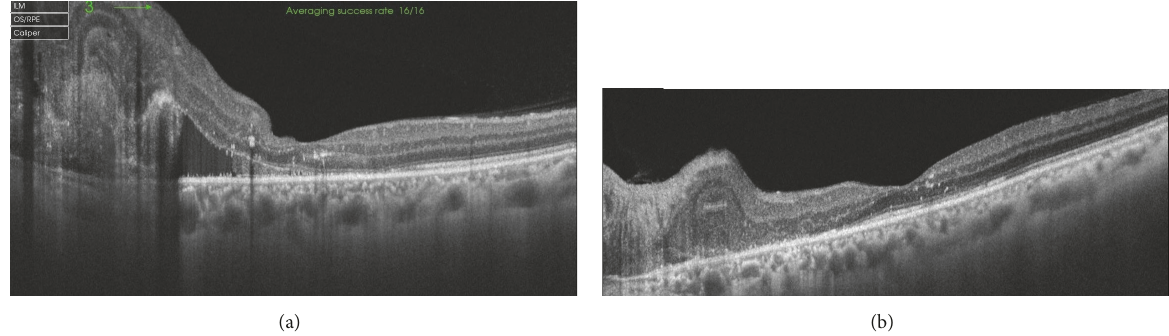
Figure 2: (a) Optical coherence tomography (OCT) showing diffuse macular thickening. (b) OCT showing complete resolution of the macular